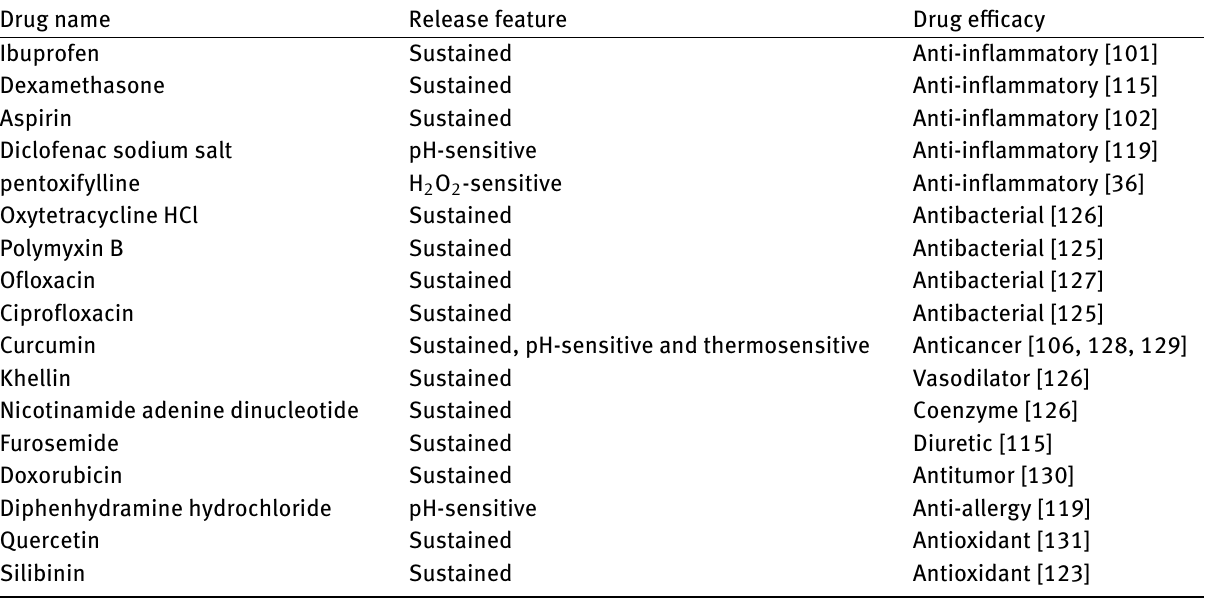
Table 3: Drug and release features in the HNTs-based drug delivery